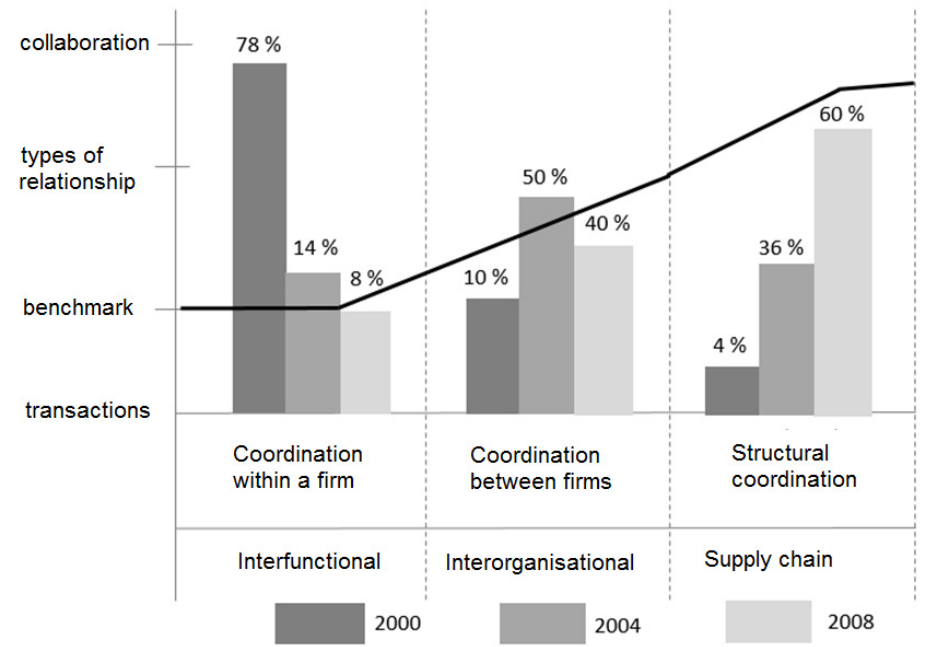
Figure 4. From interfunctional coordination to the supply chain (Source: Own study).